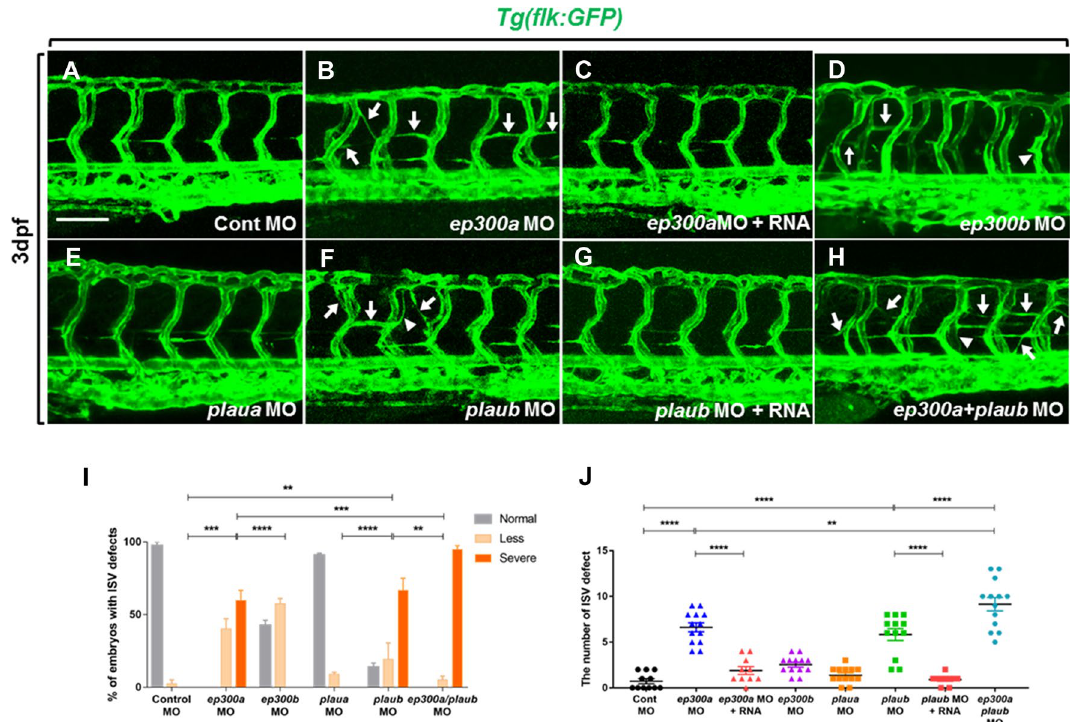
Figure 6. Knockdown of ep300a and plaub caused impaired intersegmental vessel (ISV) formation in zebrafish. Lateral views of the trunk of Tg ( flk:gfp ) zebrafish larvae (dorsal or ‘to the top’ and anterior or ‘to the left’) at 3 days post-fertilization (dpf) ( A – H ). Arrows indicate ISVs with abnormal branch formation. Arrowheads indicate ISVs with abnormal shape. Quantification of the number of embryos with ISV defects ( I ) in the control, ep300a , ep300b , plaua , and plaub morpholino (MO)-injected larvae at 3 dpf ([Control MO], normal: 97.43%, less: 2.57%, severe: 0% (n = 34); [ ep300a MO], normal: 0% less: 40.27%, severe: 59.73%, (n = 37); [ ep300b MO], normal: 43.25%, less: 56.75%, severe: 0%, (n = 37); [ plaua MO], normal: 90.97%, less: 9.03%, severe: 0%, (n = 36); [ plaub MO], normal: 11.43%, less: 8.57%, severe: 80%, (n = 35); [ ep300a / plaub MO], normal: 0%, less: 5.41%, severe: 94.59%, (n = 37)). Quantification of defective ISVs ( J ) in the control, ep300a , ep300b , plaua , and plaub MO-injected larvae and ep300a MO + RNA and plaub MO + RNA-injected larvae at 3 dpf (Control MO: 0.72 ± 0.27 (n = 11), ep300a MO: 6.62 ± 0.49 (n = 13), ep300a MO + RNA: 1.9 ± 0.43 (n = 10), ep300b MO: 2.54 ± 0.27 (n = 13), plaua MO: 1.39 ± 0.24 (n = 13), plaub MO: 5.83 ± 0.65 (n = 12), plaub MO + RNA: 0.9 ± 0.18 (n = 10), ep300a / plaub MO: 9.15 ± 0.73 (n = 13). ** p < 0.01, *** p < 0.01, **** p < 0.0001; scale bar = 100